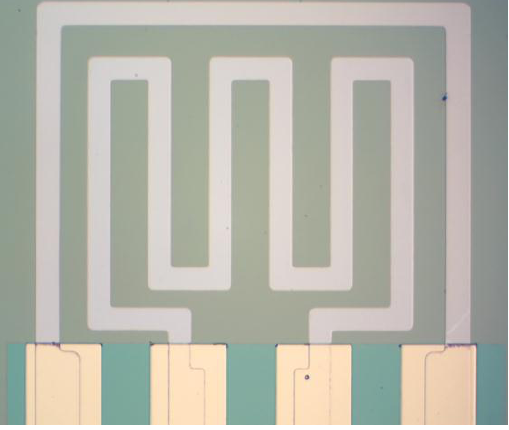
Figure 2. Photo of the fabricated hydrogen sensor.